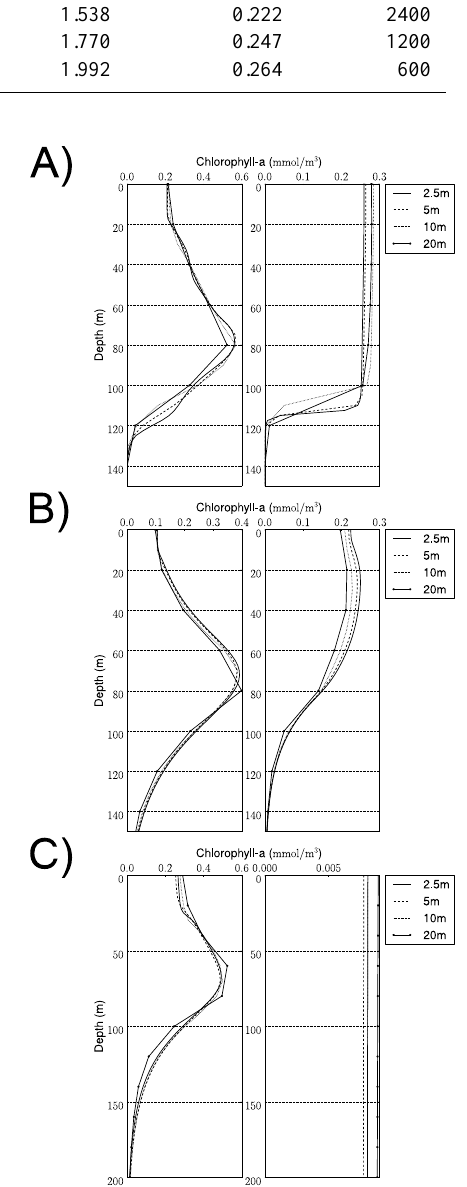
Fig. 9. Vertical profiles of chlorophyll at (A) Station Papa, (B) Bermuda and (C) Station India over the top 150, 150 and 200m respectively using uniform meshes at a number of resolutions. The left-hand column shows the profile in summer (day 182) and the right- hand side shows the column in winter (day 365). There are changes in values at key depths of upto 15% depending on the vertical resolution used.